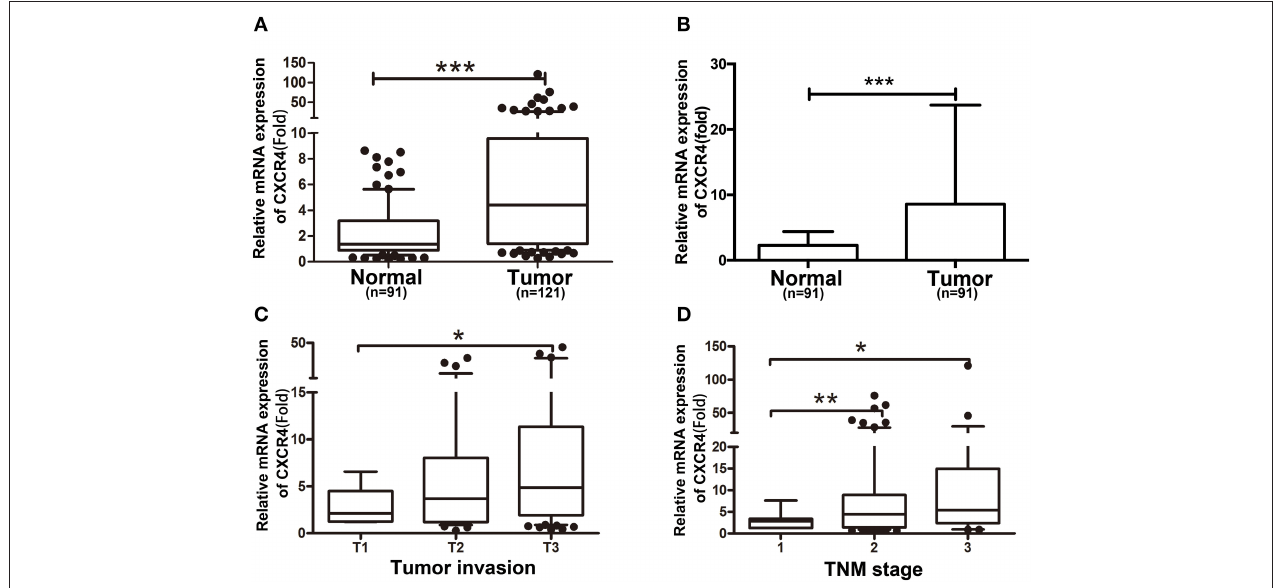
FIGURE 1 | CXCR4 expression is increased in ESCC tissues. (A) The expression of CXCR4 in neighboring non-cancerous tissues (Normal, n = 91) and ESCC tissues (Tumor, n = 121) was determined by real time PCR. (B) Expression of CXCR4 in 91 representative carcinoma tissues and their corresponding non-cancerous tissues from the same patients were analyzed side by side for comparison. The correlation of NEDD9 expression with clinicopathological characteristics such as tumor invasion (C) and TNM stage (D) was analyzed. * P < 0.05, ** P < 0.01, and *** P < 0.001.